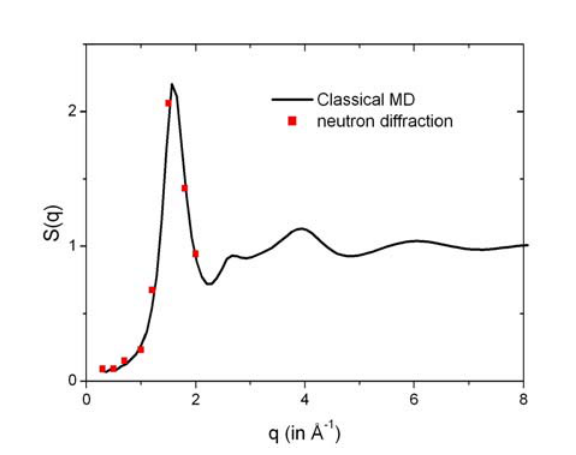
Fig. 3. Total neutron structure factor.